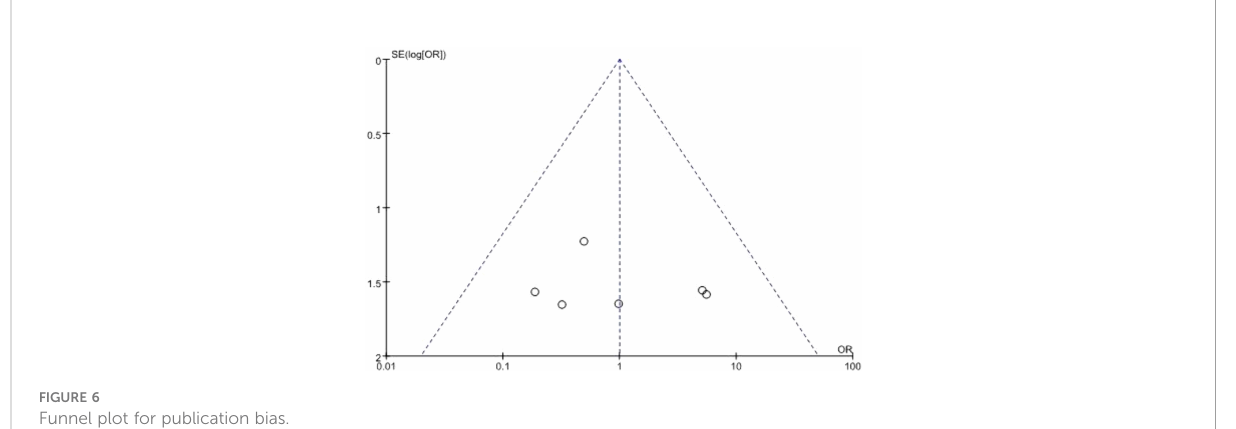
FIGURE 6 Funnel plot for publication